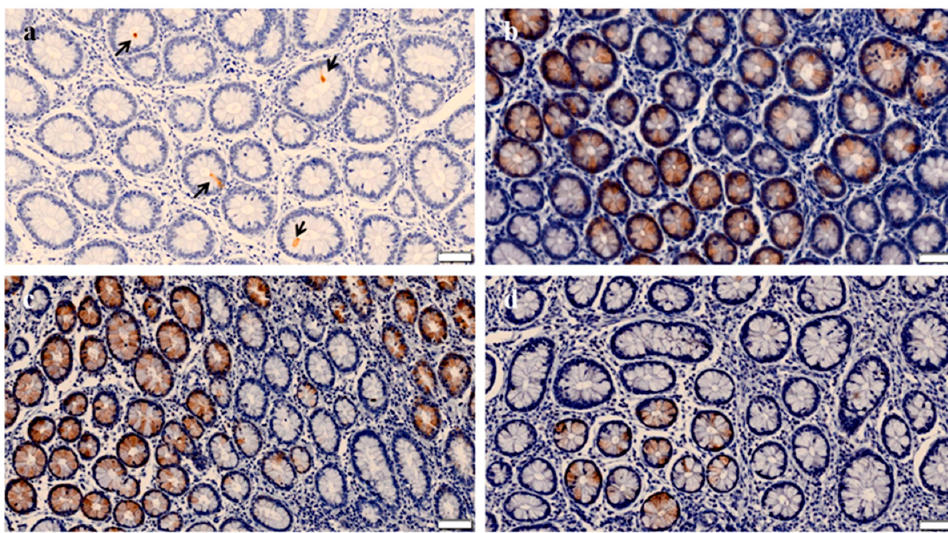
Figure 1. Immnohistochemical (IHC) analysis of ITLN2 in the ileocecal valve (ICV) of Mycobacterium avium subsp. paratuberculosis -infected and non-infected cows. Localization of ITLN2 biomarker was investigated by immunohistochemical analysis of ICV sections using a rabbit polyclonal anti-ITLN2 antibody. Representative IHC images of: ( a ) Control cow with no detected lesions; ( b ), ( c ), and ( d ) cows with focal, multifocal and diffuse types of lesions in their gut tissues, respectively, are shown. The arrows indicate sites of specific antibody binding in the goblet and Paneth cells of the crypts of Lieberkühn. Note that in all cases, the staining (brown color) occurs at the bottom of the crypts of Lieberkühn, so it is only seen in the most circular sections, which are those that correspond to the deepest invagination. Bars represent 50 microns. The mean number of immunostained cells was estimated per each individual cow (ten fields) and for each of the four established histopathological types (Table 2). The group of animals with focal lesions showed the highest mean number of ITLN2 im- munostained cells per cow (116.9 ± 16.1), followed by the groups with multifocal (108.7 ± 19.9) and diffuse lesions (76.50 ± 13.8). The control group showed the lowest mean number